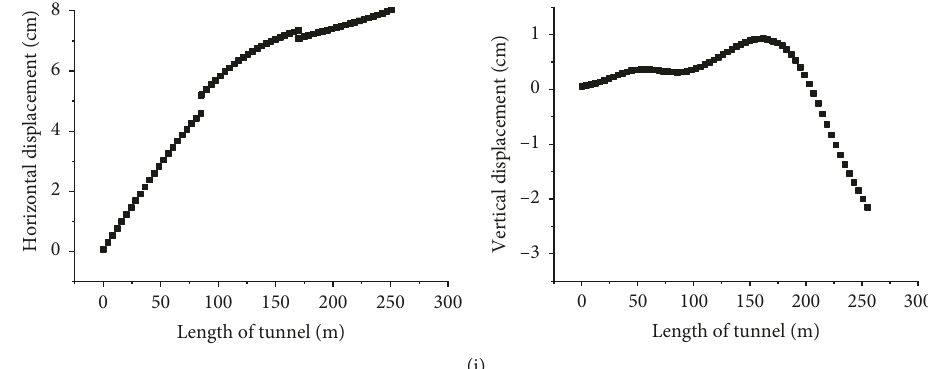
Figure 11: Horizontal and vertical displacements of immersed tunnel at different incident angles. (a) Horizontal and vertical displacement of immersed tunnel under (0 ° , 0 ° ); (b) horizontal and vertical displacement of immersed tunnel under (0 ° , 15 ° ); (c) horizontal and vertical displacement of immersed tunnel under (0 ° , 30 ° ); (d) horizontal and vertical displacement of immersed tunnel under (30 ° , 0 ° ); (e) horizontal and vertical displacement of immersed tunnel under (30 ° , 15 ° ); (f) horizontal and vertical displacement of immersed tunnel under (30 ° , 30 ° ); (g) horizontal and vertical displacement of immersed tunnel under (60 ° , 0 ° ); (h) horizontal and vertical displacement of immersed tunnel under (60 ° , 15 ° ); (i) horizontal and vertical displacement of immersed tunnel under (60 ° , 30 °